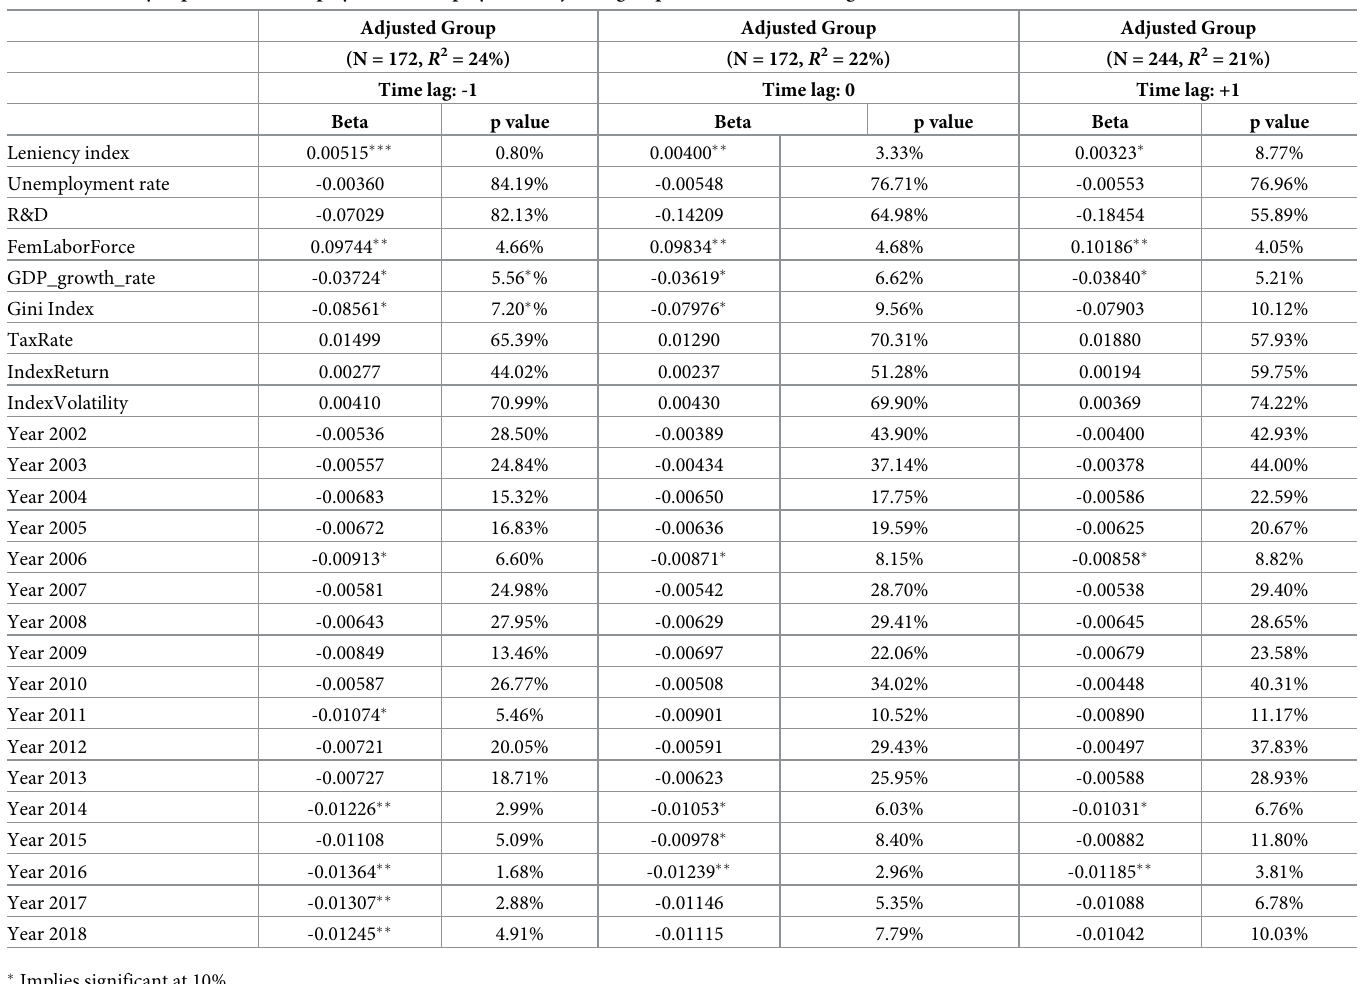
Table 3. Leniency of personal bankruptcy and self-employment–adjusted group with different time